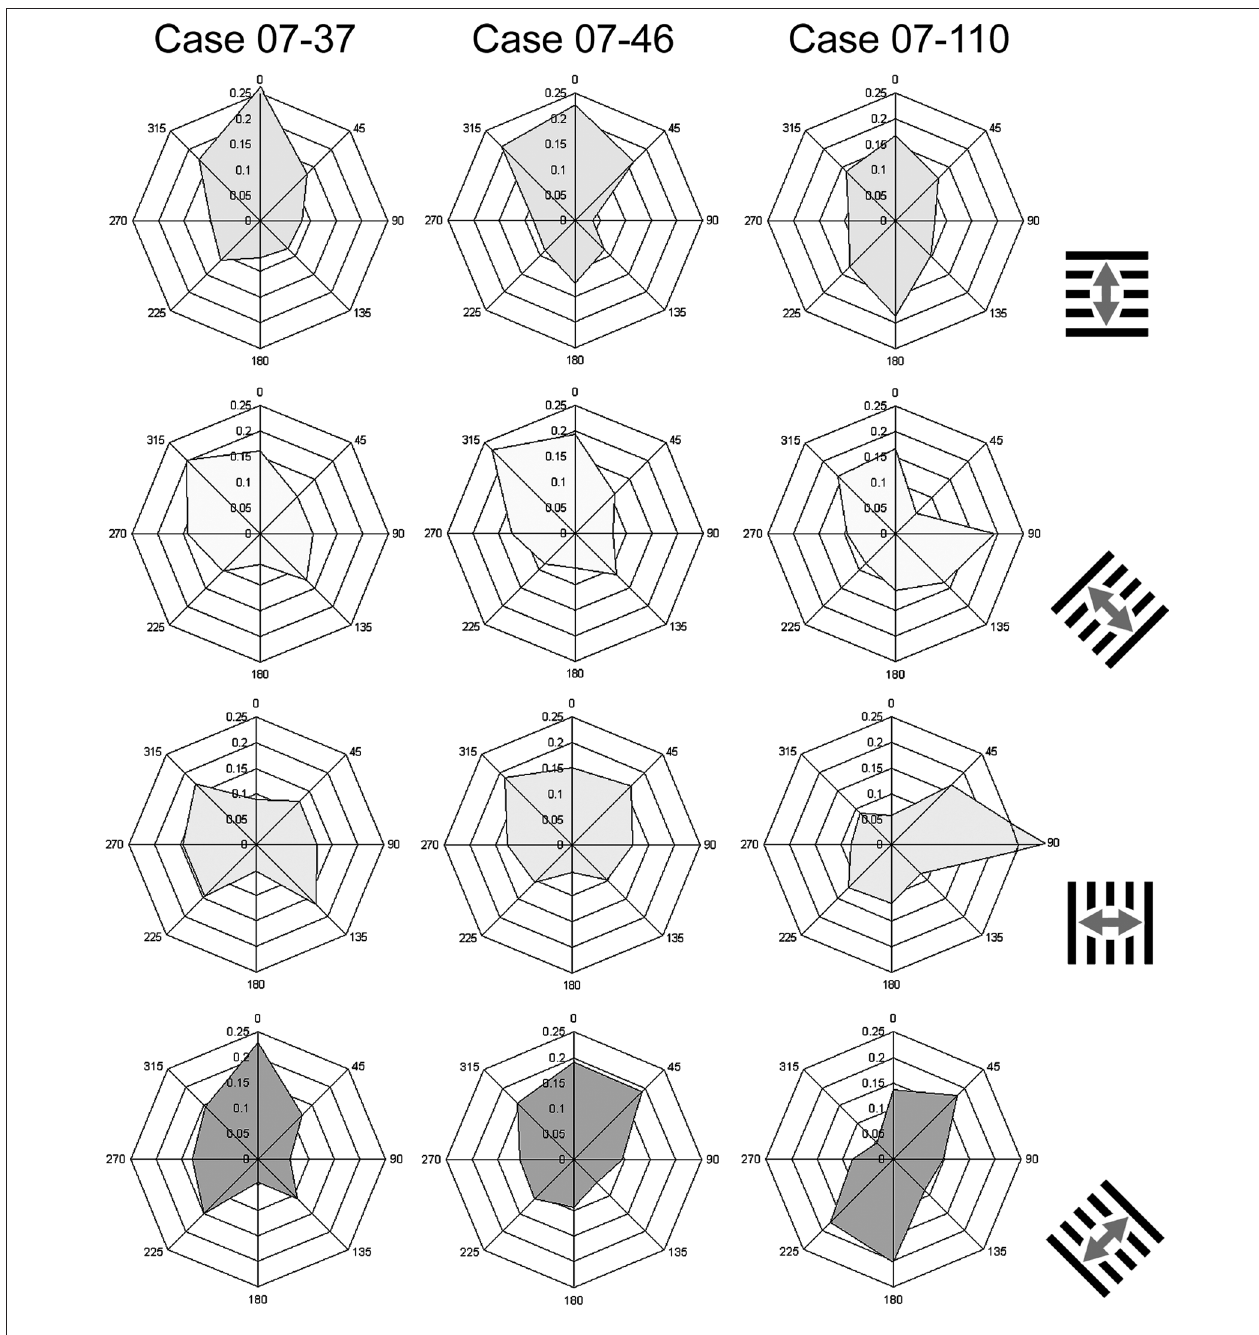
study. Note that the long axis of these radial plots is approximately parallel to the direction of the moving grating, indicated at the right, and orthogonal to the orientation of the grating. The values on the radial plots are normalized values (see Materials and Methods, Figure 5